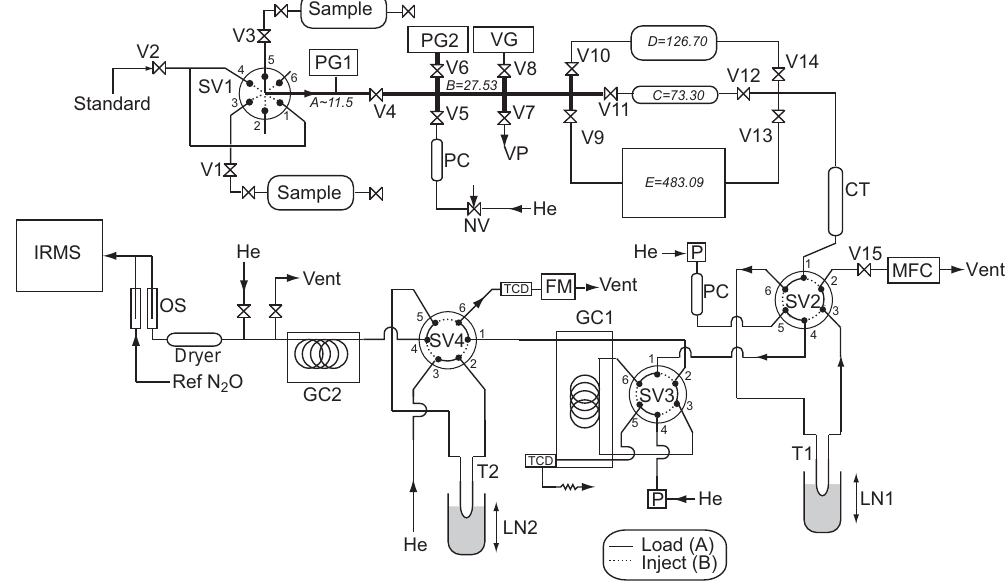
Figure 1. Schematic portraying the sample preparation system developed in this study: CT, chemical trap; FM, flow monitor; GC, gas chromatograph; IRMS, isotope ratio mass spectrometer; LN, liquid nitrogen; MFC, mass flow controller; NV, needle valve; OS, open split interface; P, pressure regulator; PC, purification column; PG, pressure gauge; SV, electrically actuated switching valve; T, trap; V, air-actuated diaphragm valve; VG, vacuum gauge; VP, vacuum pump. A–E denote parts of the vacuum line or glass bottles that are used to expand the sample, the volume (cm 3 ) of which is also